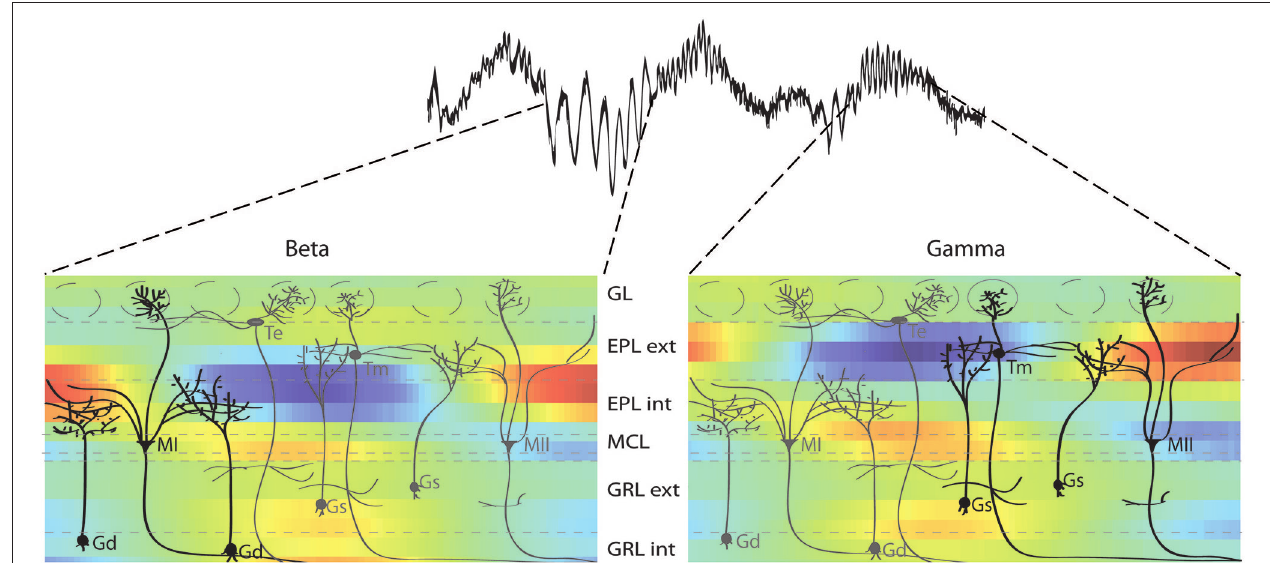
secondary dendrite arborization in the external EPL. In contrast, beta oscillations involve more type I mitral cells (in black on the left panel) with secondary dendrites mainly in the internal EPL. There is a similar segregation in the GRL. Cell name abbreviations: MI: type I mitral cell; MII: type II mitral cell; Gs: superficial granule cell; Gd: deep granule cell; Te: external tufted cell; Tm: middle tufted